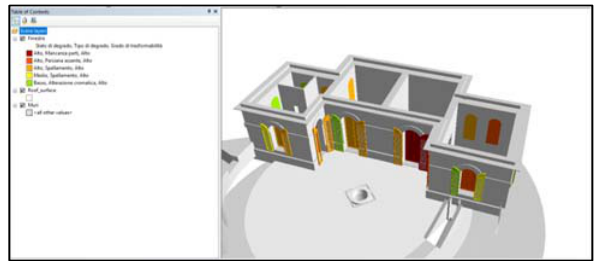
Figure 8. Selection of the windows with high degradation level in Arcscene